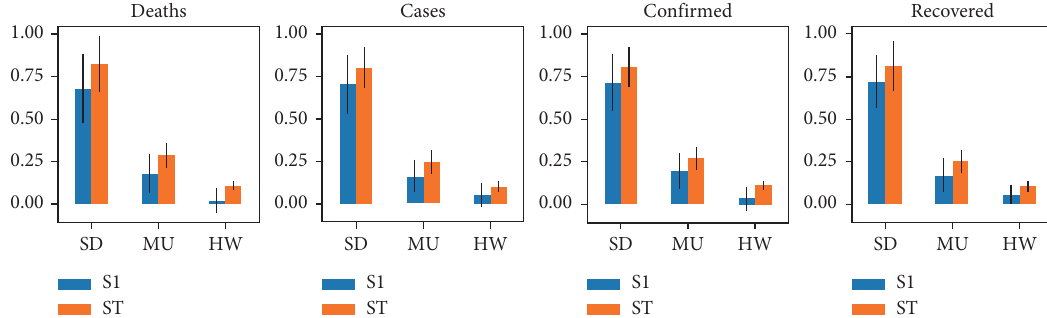
Figure 10: Sensitivity indices for first (S1) and total order (ST) variabilities of input parameters on each of the outcome variables, with a 95% confidence